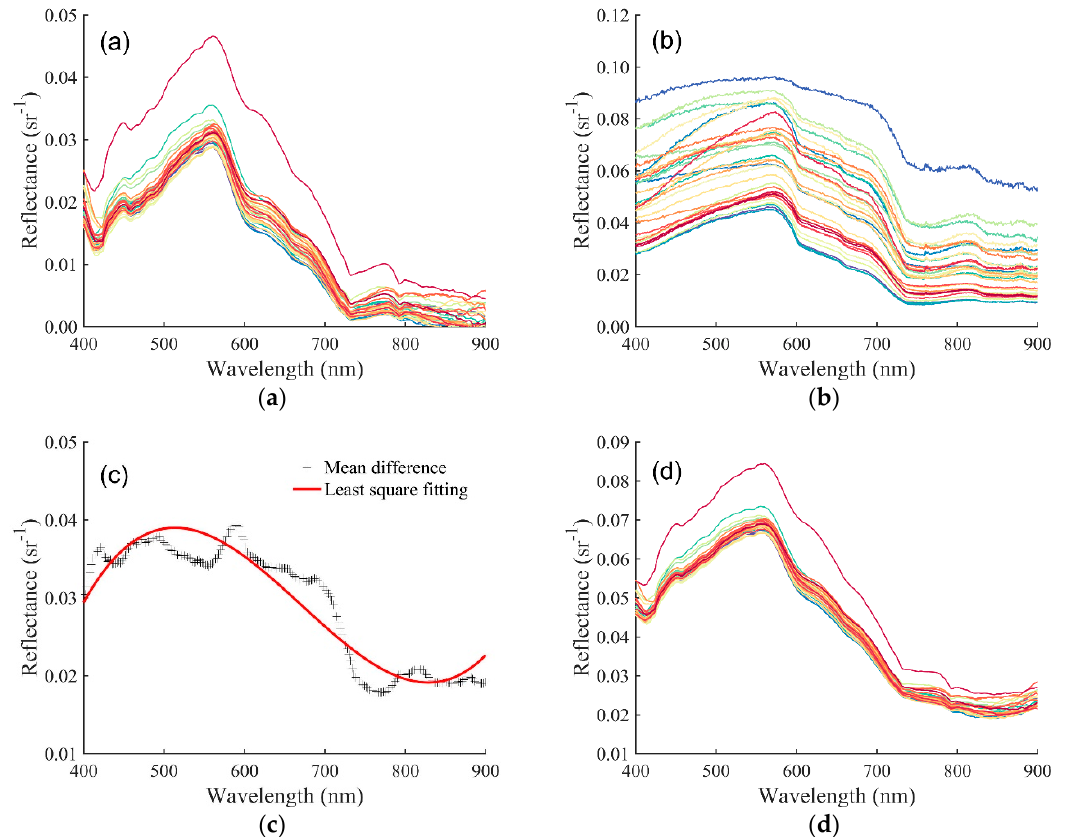
Figure 5. Reflectance spectra from spectrum sampling sites obtained by ( a ) Pika L and ( b ) QE Pro; ( c ) least square fitting of the mean differences between shipborne and airborne spectra; and ( d ) spectra after spectral correction.